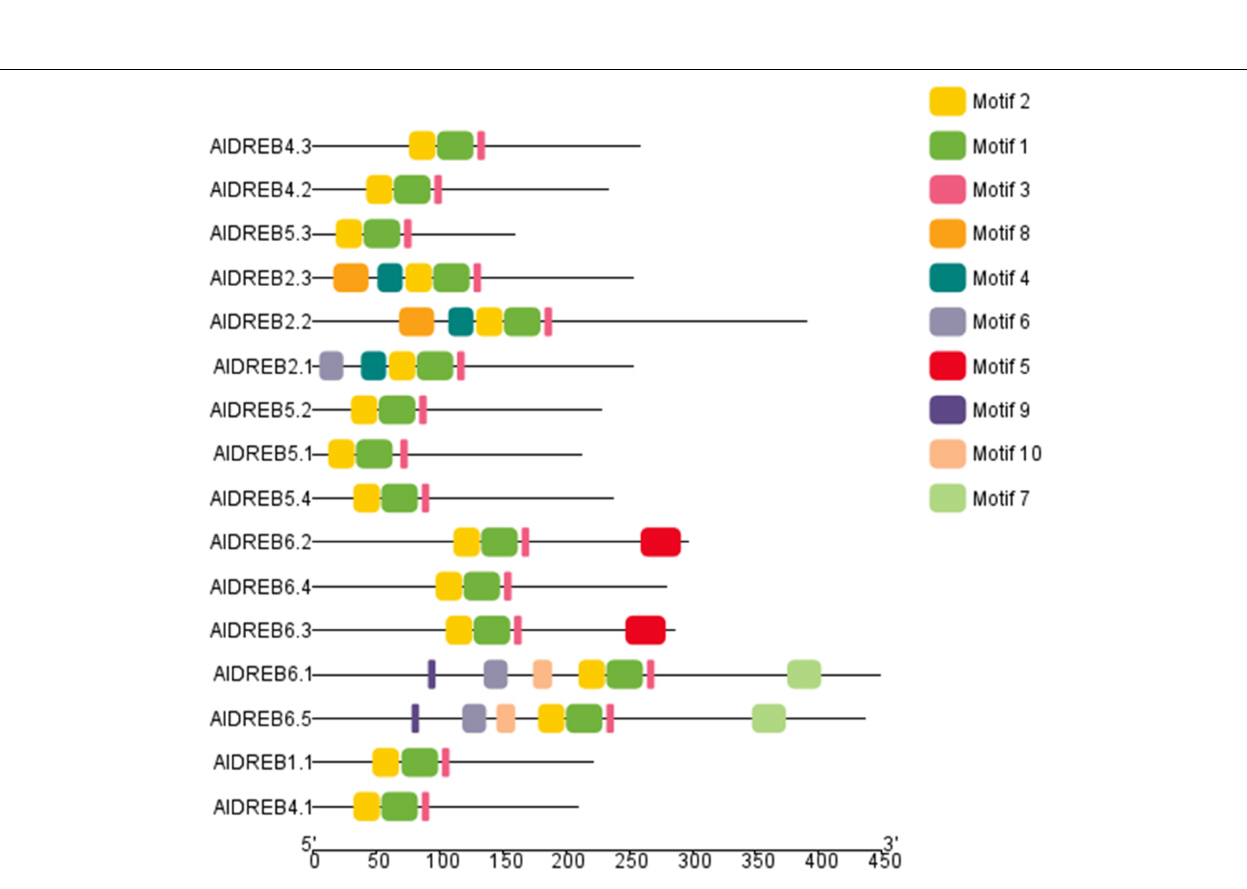
FIGURE 5 | Structure of identified DREB related proteins in Aeluropus littoralis . Based on the available sequence information 16 DREB gens could be identified encoding proteins with DREB associated motifs. Detailed motif information is given in the Supplementary Table 5 . Motif 1, 2 and 3 depict the AP2-superfamily defining